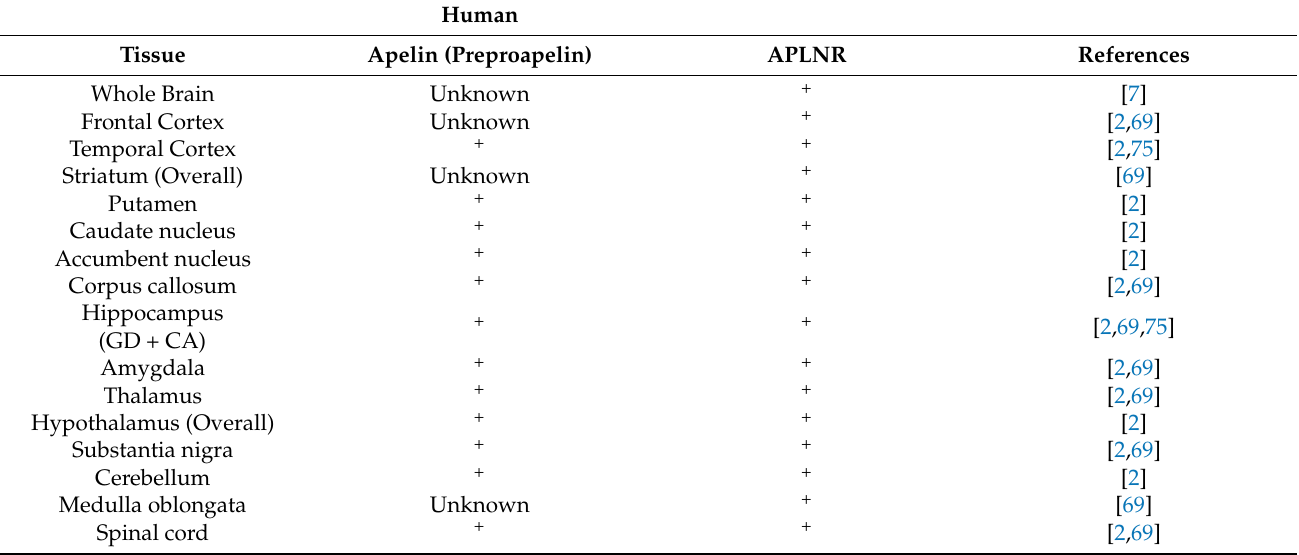
Table 1. Table with different brain regions in the human brain with known expression of APLNR and Apelin ligand.